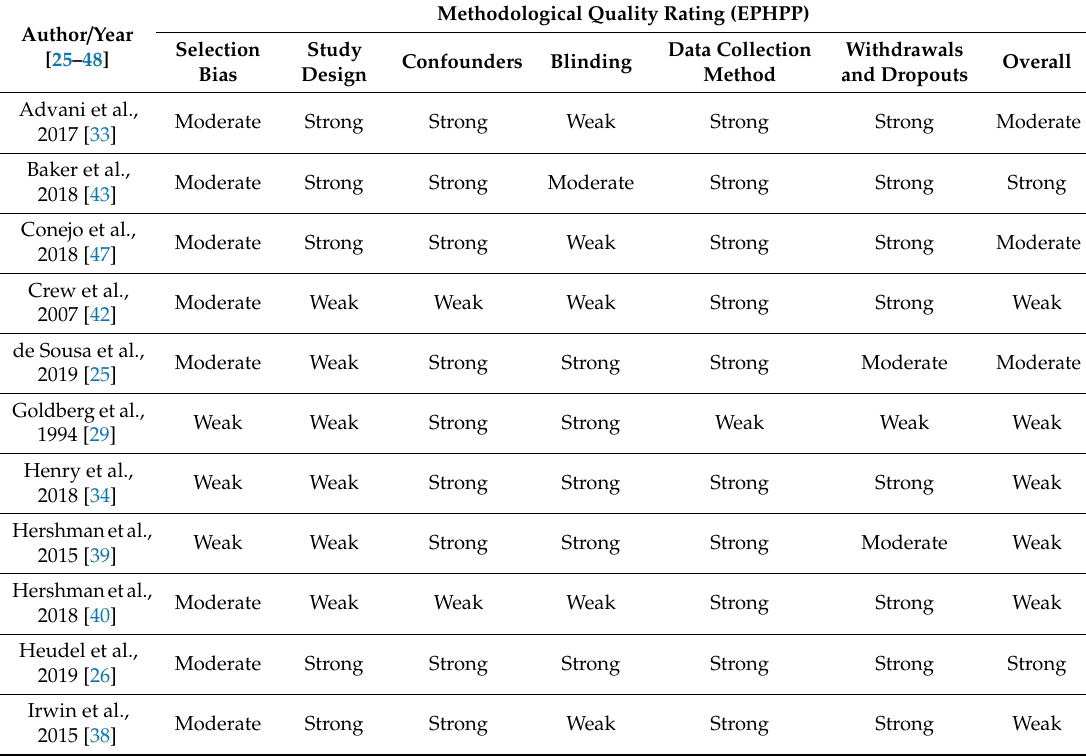
Table 2. The methodological quality of the included